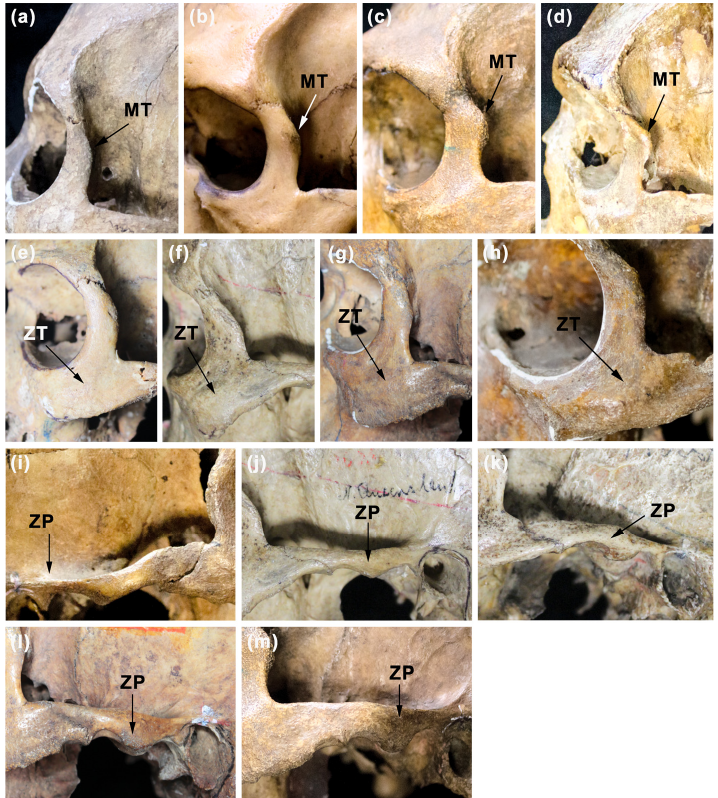
Figure 3. The regions of the facial skeleton assessed in the examined human skulls in terms of their degree of massiveness expression: MT—malar tubercle (( a ) the margin is smooth, lack of bone elevation; ( b ) grade 2, a slight elevation of the posterior margin of this process (triangular in shape) is visible; ( c ) grade 3, the area of this elevation is greater than in the case of the second grade and rounded or a small convexity can be observed at this place; and ( d ) grade 4, the margin forms a well- developed process with two edges or one edge substantially raised upwards), ZT—zygomaxillary tuberosity (( e ) grade 1, flat and smooth external surface of the malar bone; ( f ) grade 2, a small tubercle is visible; ( g ) grade 3, the tubercle is more pronounced and horizontally stretched; and ( h ) grade 4, a large tubercle in the form of a pronounced ridge located parallel to the inferior margin of this bone), and ZP—zygomatic process of temporal bone (( i ) grade 1, a very thin process and low; ( j ) grade 2, process is thin and low; ( k ) grade 3, process is medium in the case of thickness and height; ( l ) grade 4, process is thick and high; and ( m ) grade 5, process is very thick and